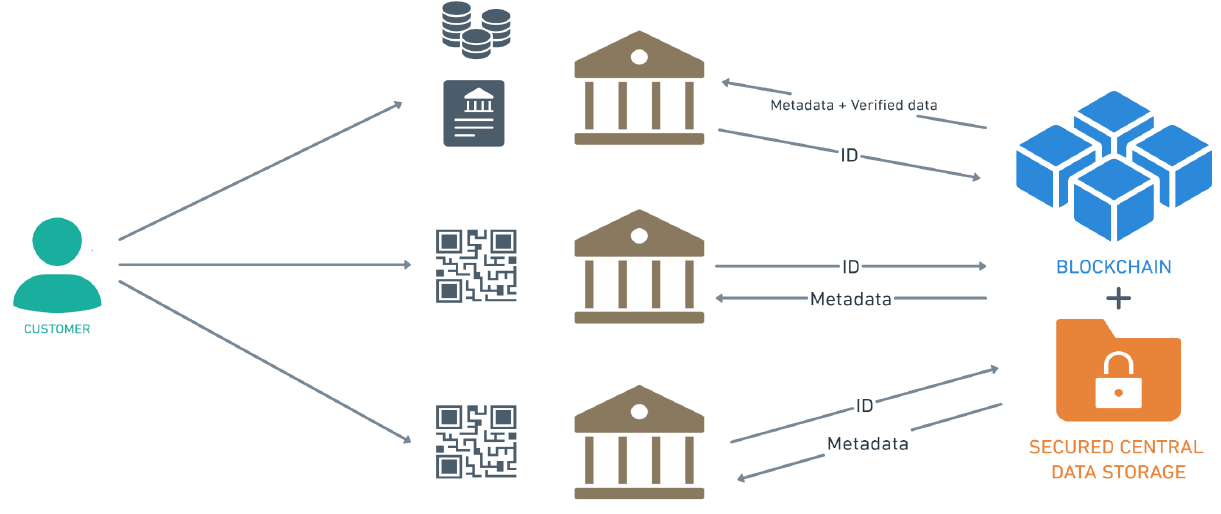
Fig. 2 . Proposed KYC